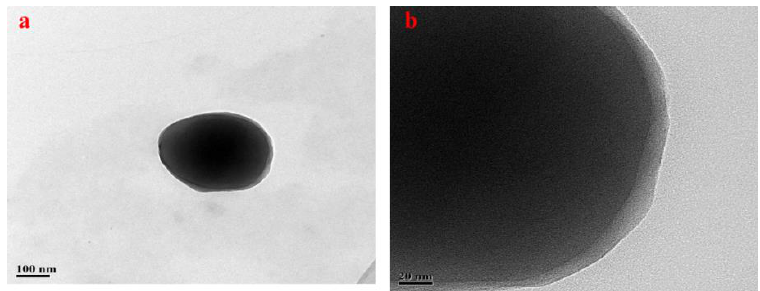
Figure 7. TEM images ( a ) and ( b ) of 560/BNNS.